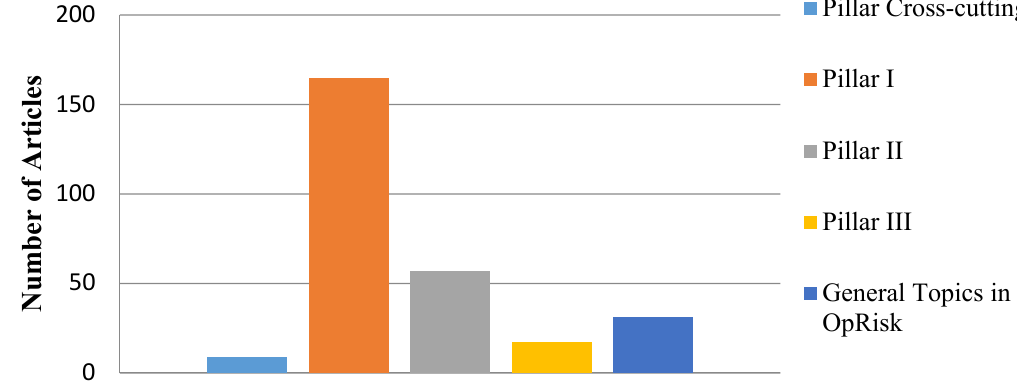
Figure 3. Classification of the identified articles into the pillars of the Basel II/III framework.